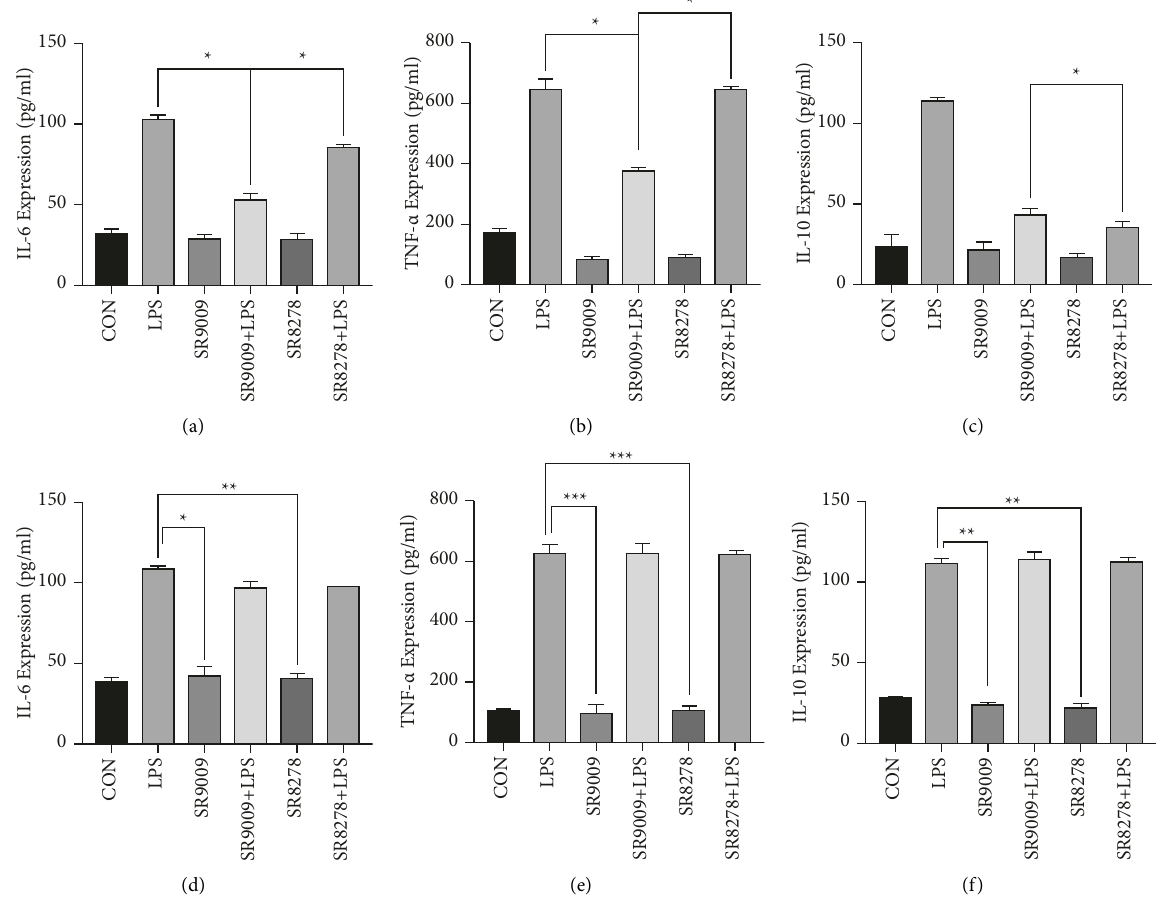
Figure 3: The analysis of the relative expression of Rev-Erb α activation by SR9009 and SR8278 in vitro. ELISA detection of proinflammatory cytokine production: (a) IL-6, (b) TNF- α , and (c) anti-inflammatory cytokine production IL-10 in RAW246.7 cells after treatment with DMSO (control group), LPS, SR9009, SR9009+LPS, SR8278, and SR8278 +LPS; knock-down of Rev-Erb α in RAW246.7 cells aggravated the inflammatory response: (d) IL-6, (e) TNF- α , and (f) IL-10 in RAW246.7 cells. Significant differences: ∗ p < 0 . 05, ∗∗ p < 0 . 01, and ∗∗∗ p < 0 .